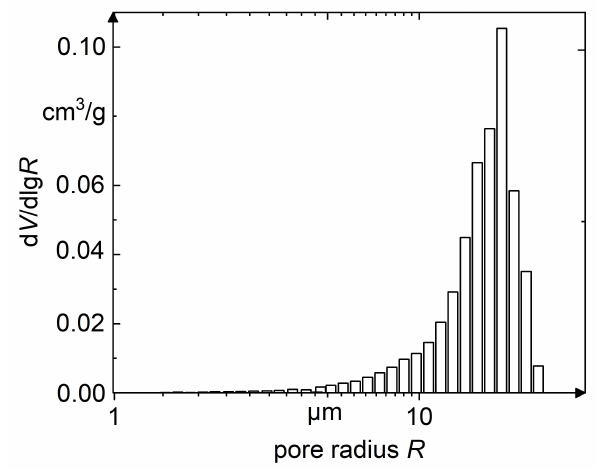
Figure A1. Pore radius distribution of the PMMA powder; plotted as a logarithmic-differential pore volume distribution for a better